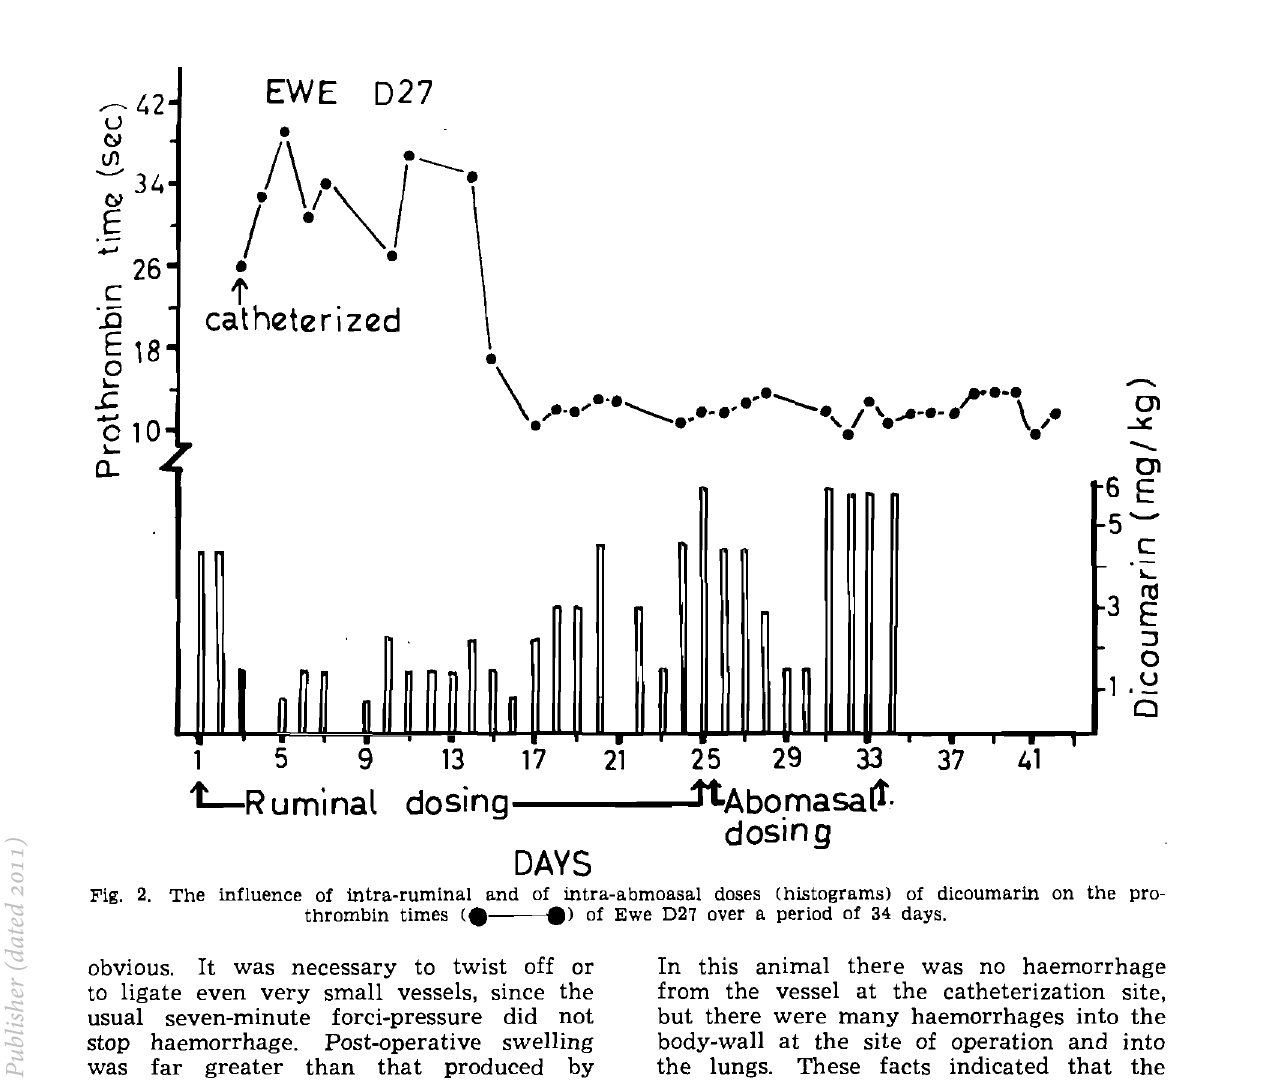
Fig. 2. The influence of intra-ruminal and of intra-abmoasal doses (histograms) of dicoumarin on the pro- thrombin times (. .) of Ewe D27 over a period of 34